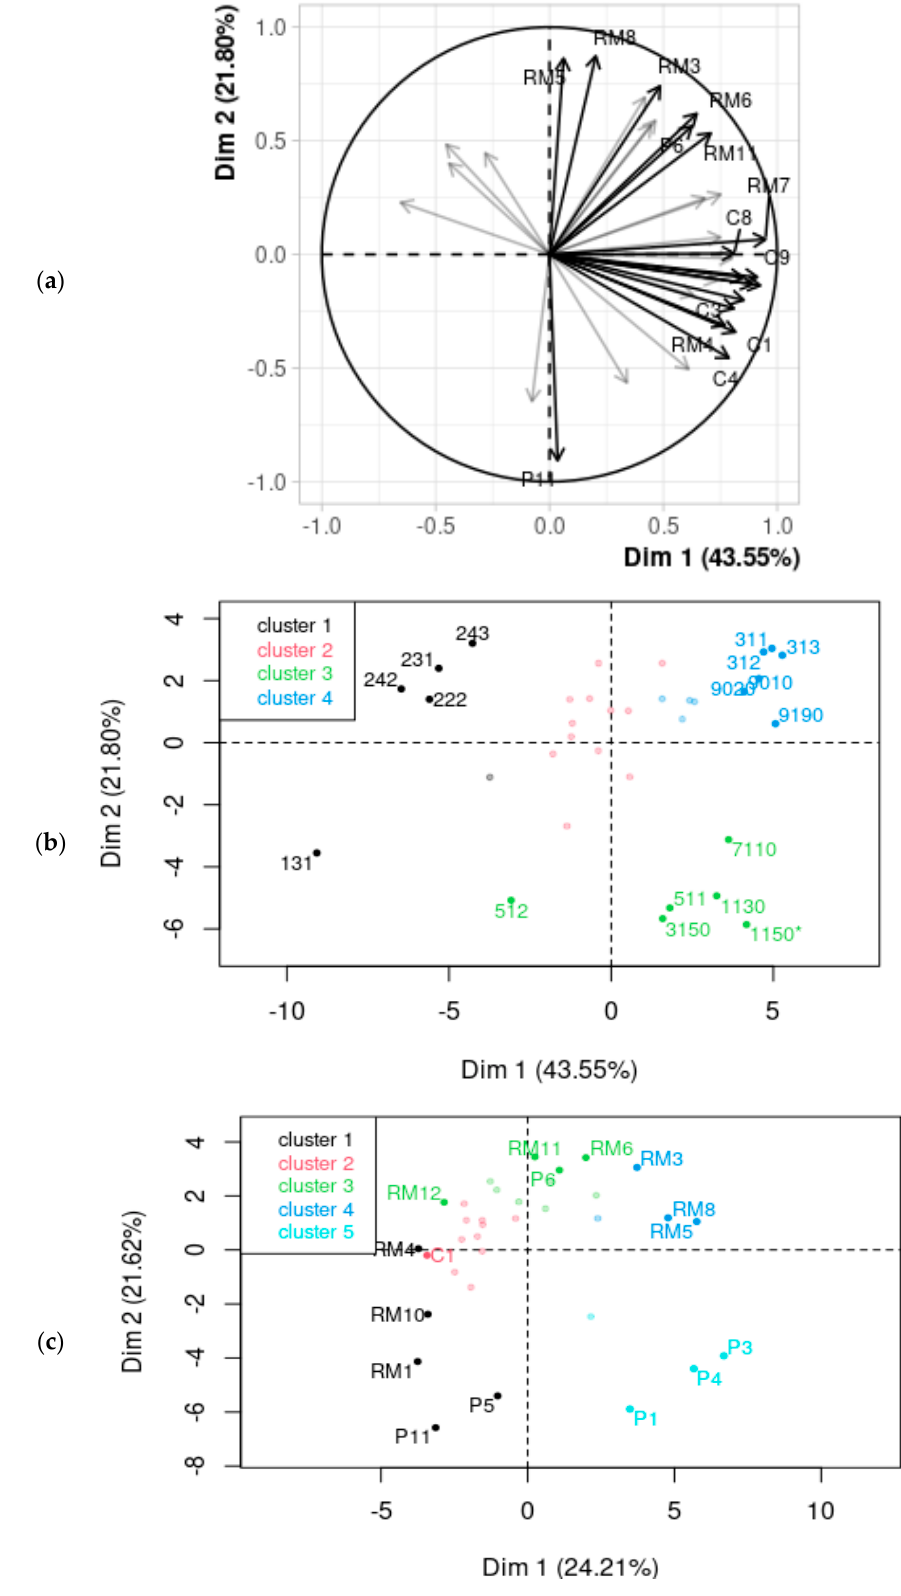
Figure 4. Variables factor map (principal component analyses) ( a ); ascending hierarchical classifica- tion of the land use classes ( b ) and ecosystem services, based on reversed matrix ( c ).